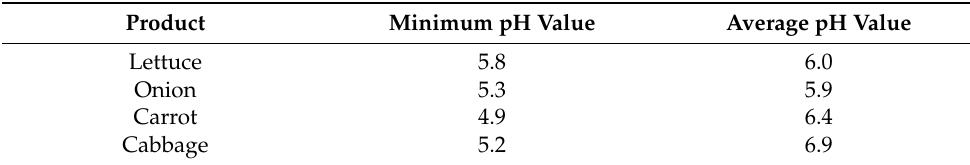
Table 2. Potential of hydrogen intervals for each horticultural